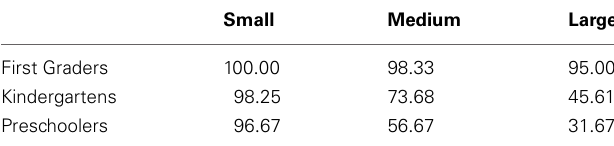
Table 5 | Percentages of correct responses in the Give- N task as a function of School level and Numerosities of